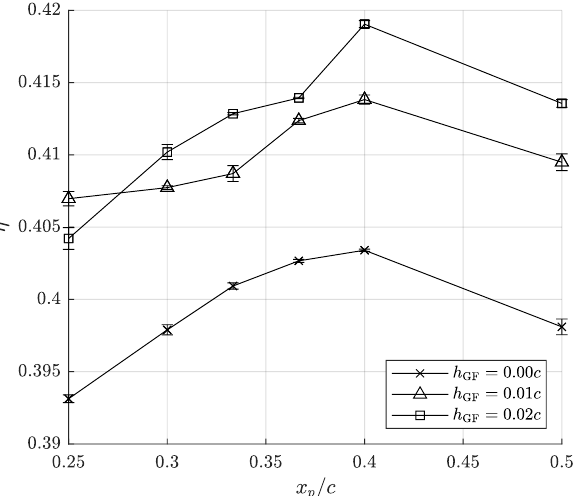
Figure 12. Effect on performance of fitting double GFs on OFTs with different pivot-point locations ( x p ) at f ∗ = 0.18 and α 0 = 29 ◦